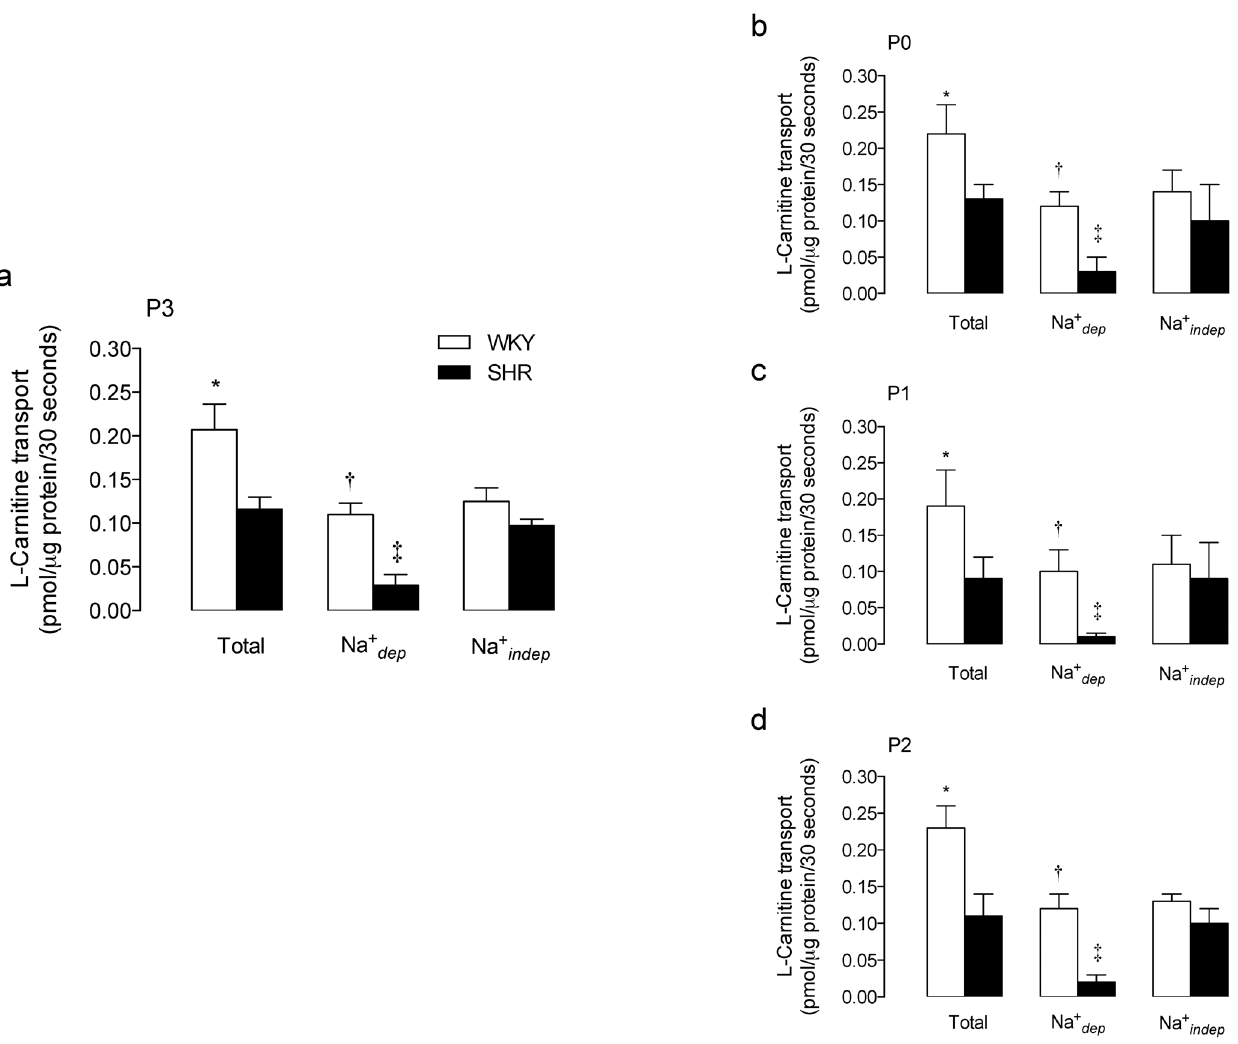
Figure 1. Transport of L-carnitine in RAECs. Total, Na + -dependent (Na + dep ) and Na + -independent (Na + indep ) L-carnitine transport (20 m mol/L, 3 m Ci/mL L-[ 3 H]carnitine, 30 seconds, 37 u C) in RAECs from WKY rats or SHR. Transport was assayed in RAECs in passage 3 (P3) (a) and compared with cells in passages 0 (P0) (b), 1 (P1) (c) or 2 (P2) (d). * P , 0.05 versus all other values, { P , 0.05 versus corresponding Na + dep values in SHR, ` P , 0.05 versus all other values in SHR. Values are mean 6 SEM